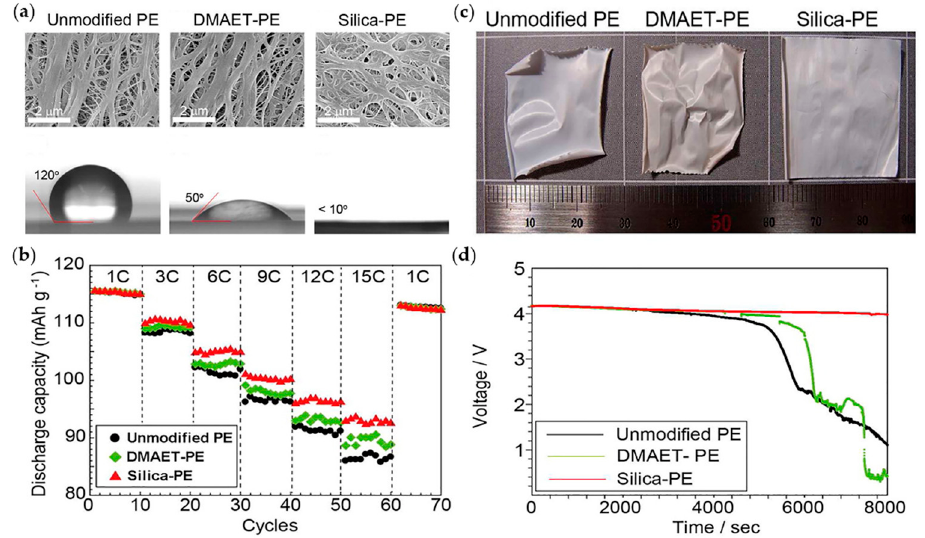
Figure 3. ( a ) SEM and water contact angle images of various membranes. ( b ) Rate capabilities of the di ff erent separators (1 C for charge and various C-rates for discharge). The anode and cathode are graphite and LiMn 2 O 4 , respectively. ( c ) Digital images of the di ff erent separators after exposure to 140 ◦ C for 1 h. ( d ) Open circuit voltage measurements of the cells with various separators at 140 ◦ C. Reprinted with permission from [51]. Copyright (2012) American Chemical Society.